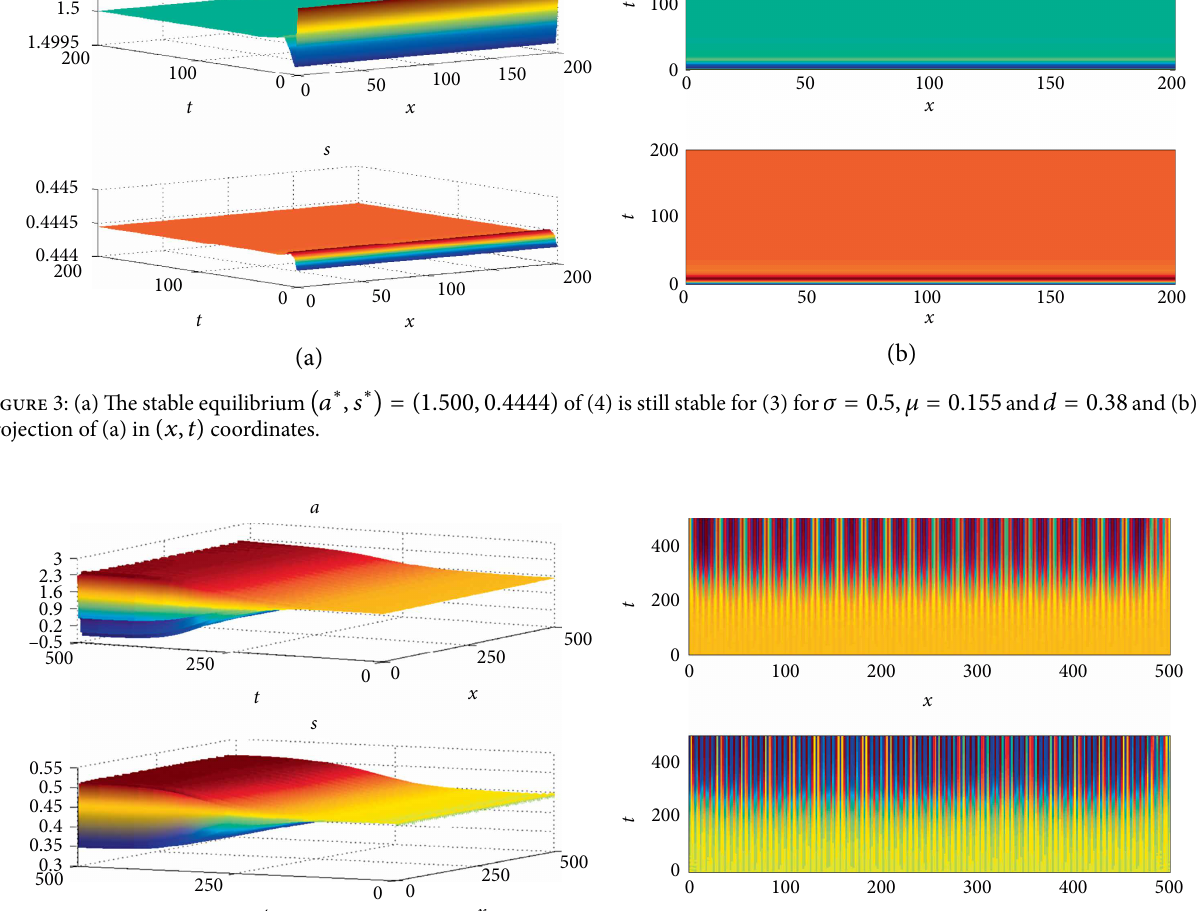
of (4) is still stable for (3) for